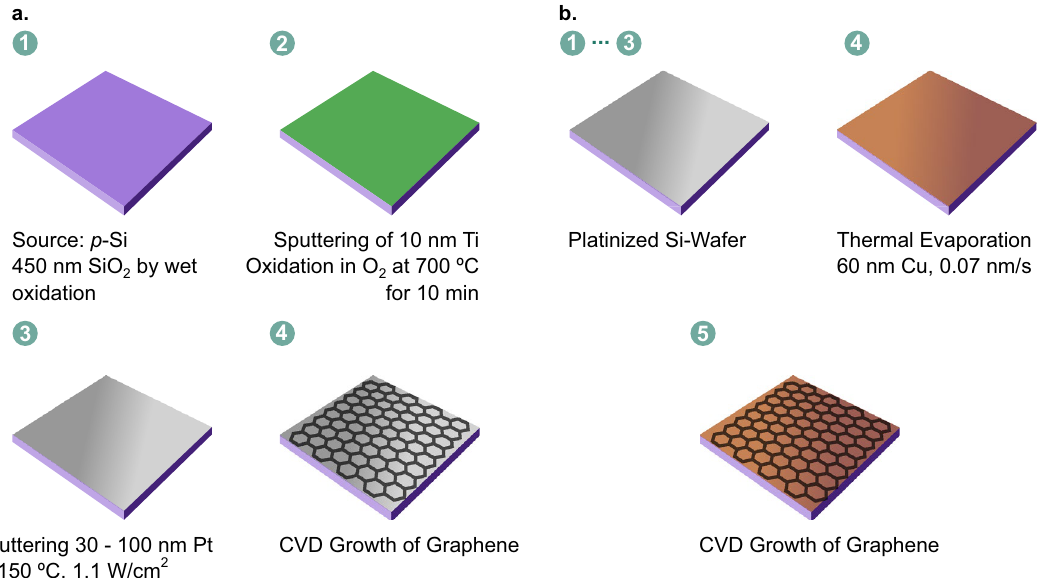
Fig. 1 Schematic process flow for graphene growth on a Pt and b Pt–Cu thin-films. Labels (1)–(5) indicate individual process steps such as Pt sputtering or Cu thermal